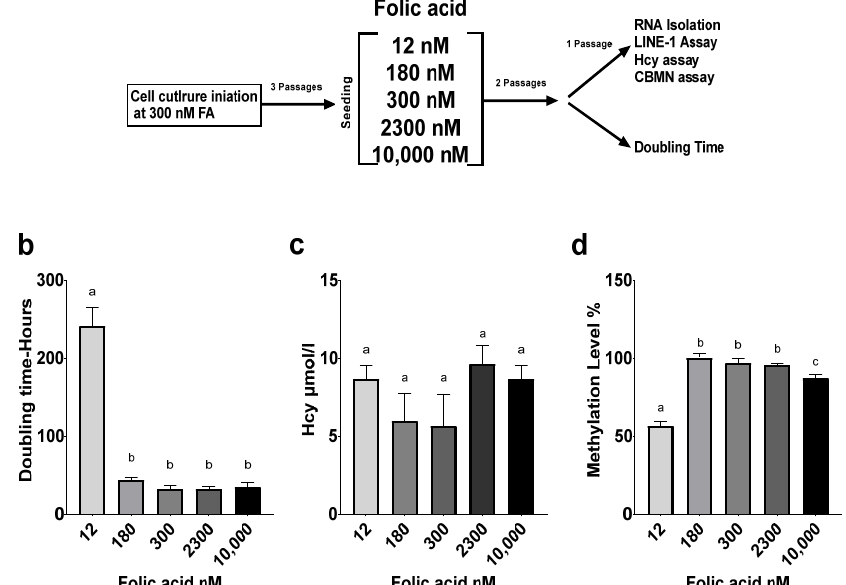
Figure 1. Impact of folate supplementation on proliferation, homocysteine levels, and DNA methylation in human lymphoblastoid cell line. ( a ) Study design. ( b ) Effect of FA media concentration on LCL proliferation. ( c ) Effect of FA media concentration on LCL homocysteine levels. ( d ) Effect of FA media concentration on global DNA methylation through LINE1 Assay. Results are from technical triplicates ( n = 3). Bars, SEMs, and means with different letters (a,b,c) are significantly different (Tukey’s HSD, p < 0.05).